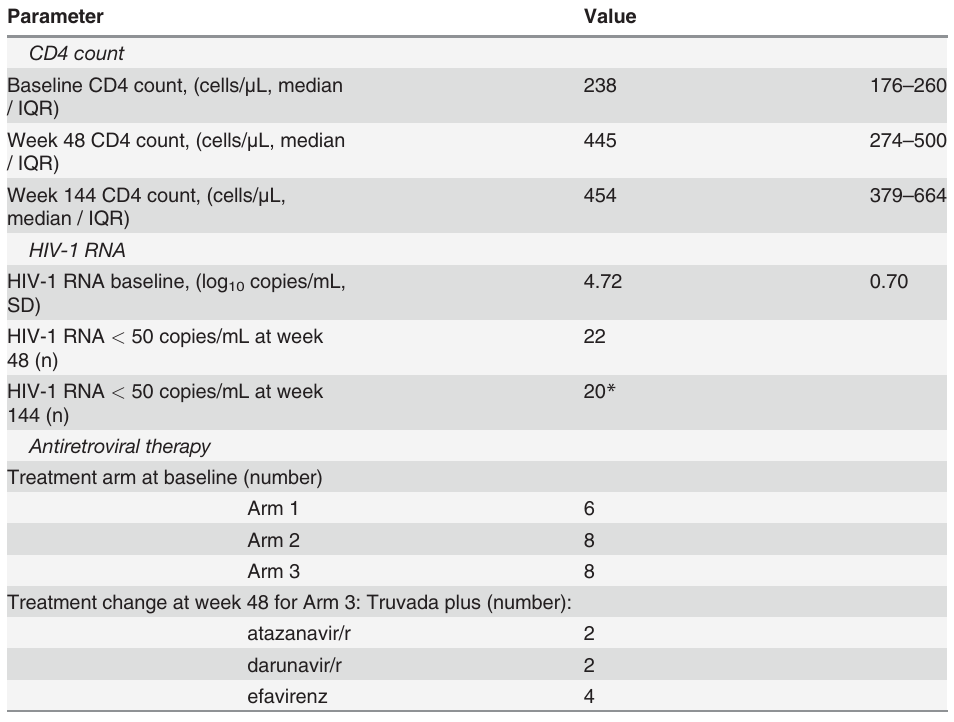
Table 1. Subject characteristics (n =